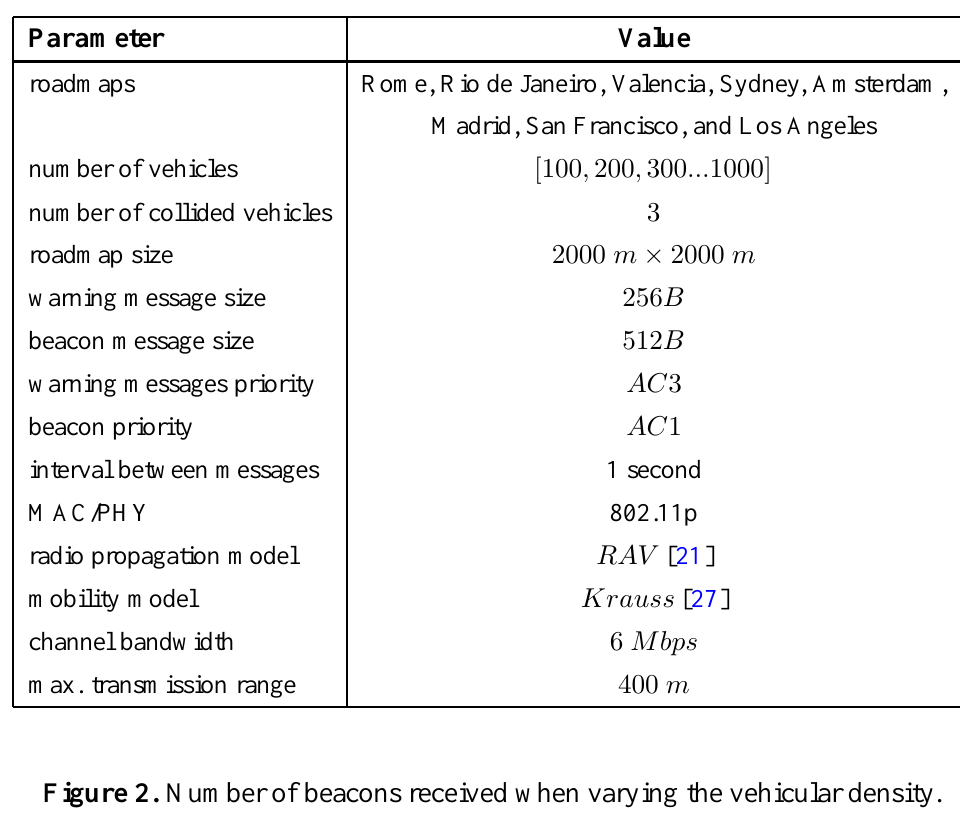
Table 2. Parameters used for the simulations.